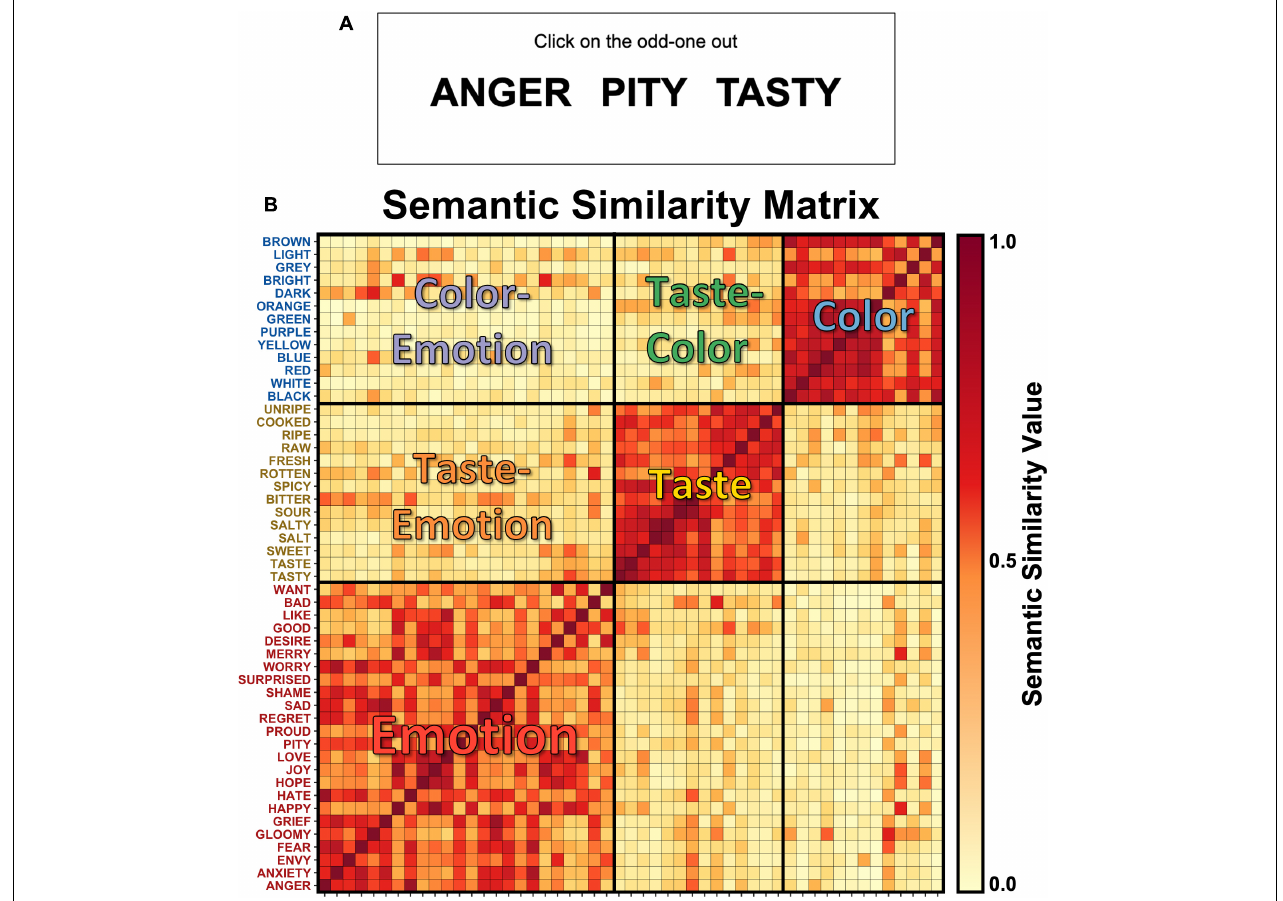
FIGURE 1 | The semantic similarity of Taste, Color, and Emotion concepts. (A) In an online behavioral task, we asked participants to select the “odd-one-out” from a series of three-word prompts, each containing concept words related to taste, emotion, or color. (B) The data from this task were used to create a similarity matrix, which indicated the semantic similarity of each pair of concepts. The pairwise semantic similarity values in the matrix reflect the observed probability that neither word in a pair was selected as the odd-one-out during the behavioral